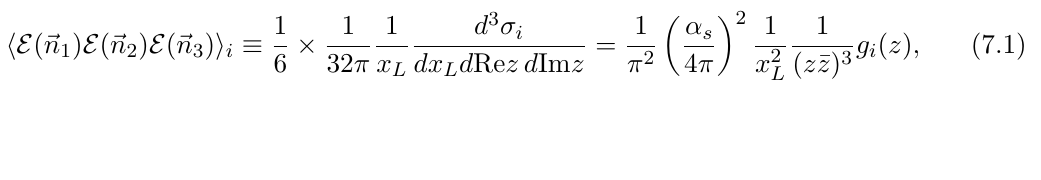
+ c u j +6 ,j j +6 ,j